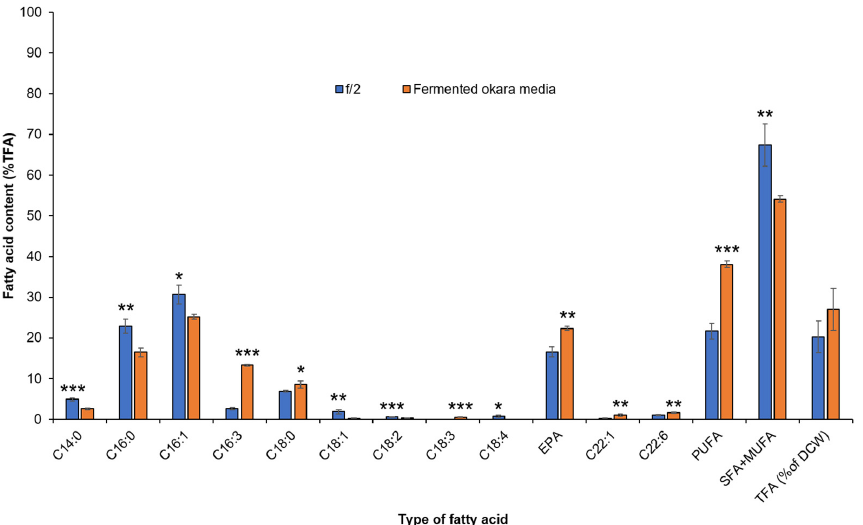
Figure 3. Fatty acid composition of P. tricornutum cells from F/2 and fermented okara culture. Statistical analysis was performed by Student’s 2-tailed t test. * p < 0.05, ** p < 0.01, *** p < 0.001.